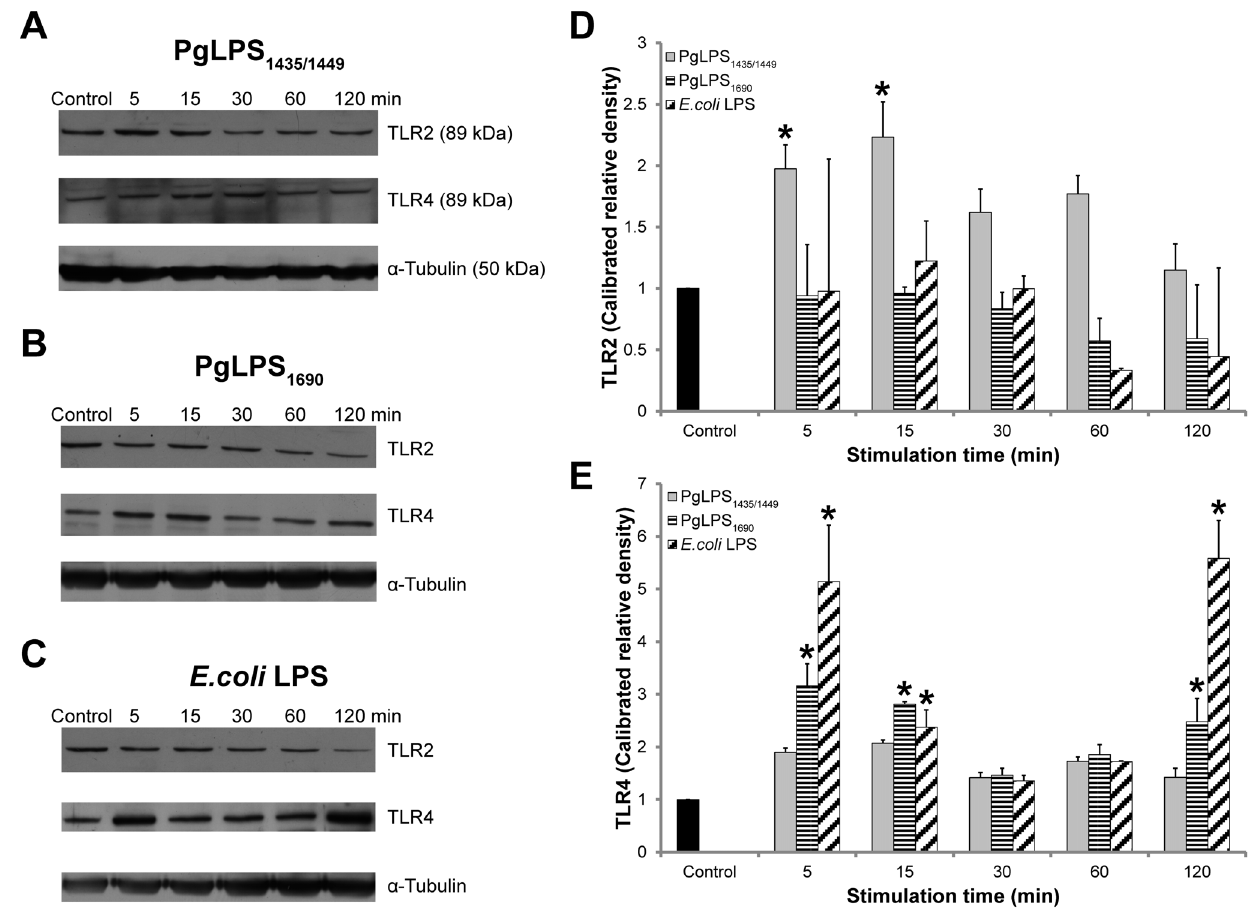
Figure 2. TLR2 and TLR4 protein expression in P.gingivalis LPS- and E.coli LPS-stimulated HGFs. Confluent HGFs were stimulated with P. gingivalis (Pg) LPS 1435/1449 ( PgLPS 1435/1449 ) 1435/1449 (A, D and E), PgLPS 1690 (B, D and E) and E. coli LPS (C, D and E) (1 m g/mL) at the indicated time points in the western blot analysis for assay of TLR2 and TLR4 protein expression. 40 m g of homogenized cellular extracts were subjected to SDS- PAGE and probed with anti TLR2 (1:1000) and anti-TLR4 (1:1000) polyclonal antibodies. Blots were re-probed with tubulin to confirm equal loading in individual samples. One representative blot was shown from three independent experiments with similar results, TLR2:89 kDa; TLR4:96 kDa; and Tubulin: 50 kDa. Quantification of band intensities was performed by densitometry analysis using Image J